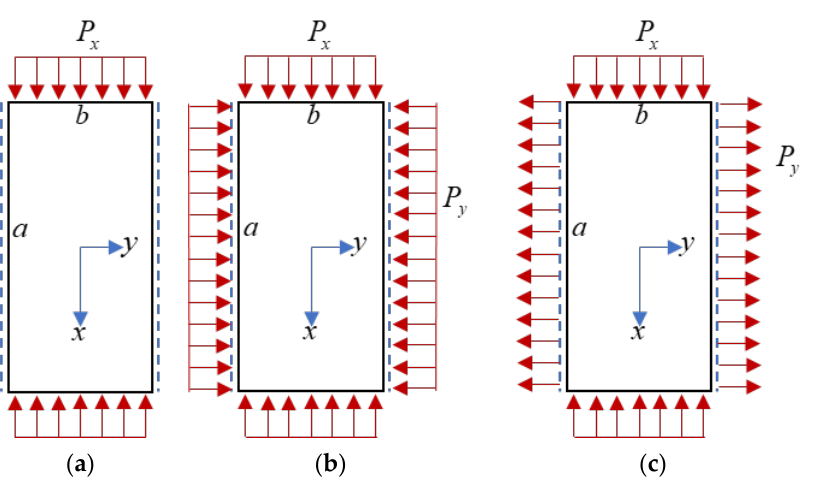
Figure 1. Stress form of buckling of the side plate. ( a ) Axial compression. ( b ) Axial compression and transverse compression. ( c ) Axial compression and transverse tension.